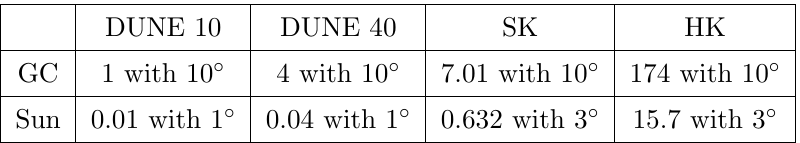
Table 2 . Expected number of background events per year with appropriate angular cut and threshold